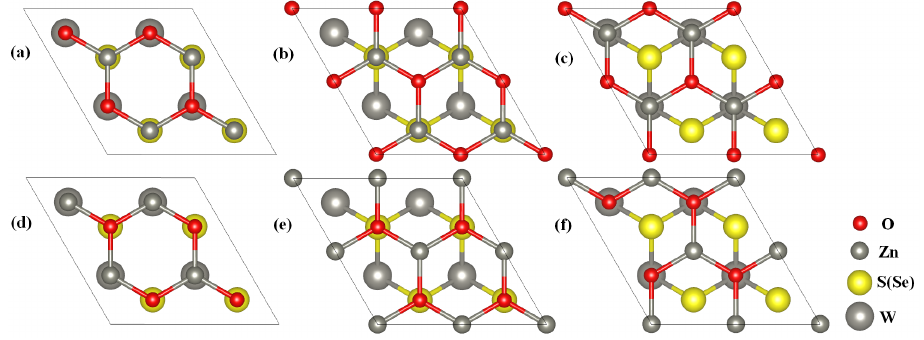
Figure 1. Top views of the ZnO/WS 2 (ZnO/WSe 2 ) with the g-ZnO in different rotation angles of ( a ) 0 ◦ (the reference); ( b ) 60 ◦ ; ( c ) 120 ◦ ; ( d ) 180 ◦ ; ( e ) 240 ◦ ; and ( f ) 300 ◦